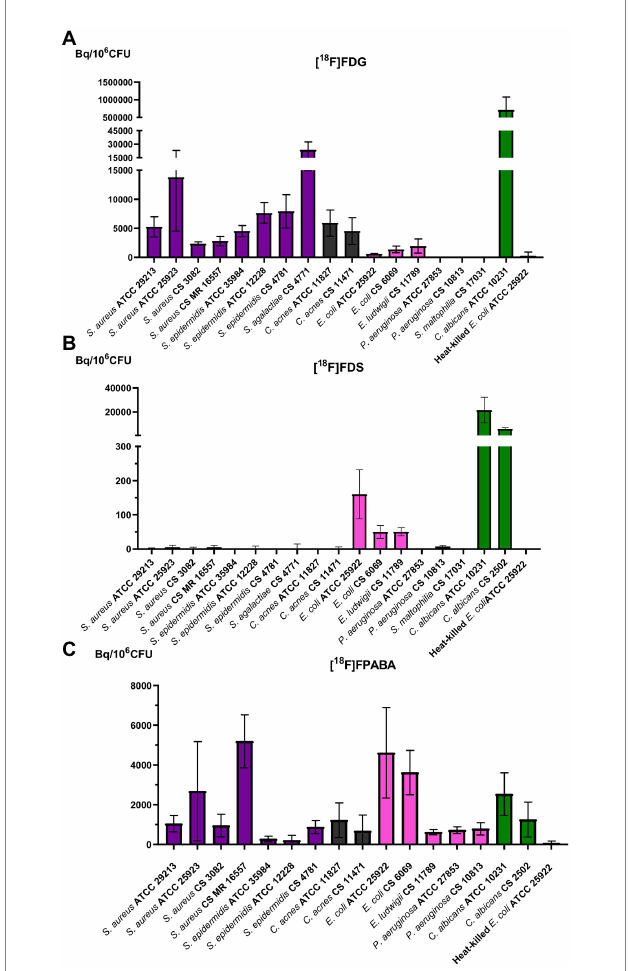
FIGURE 3 Cellular uptake of different probes tested after 2 h of accumulation. Purple: Gram-positive bacteria. Gray: Cutibacterium acnes . Pink: Gram-negative bacteria. Green: yeasts. CS: clinical strain. (A) [ 18 F]FDG; (B) [ 18 F]FDS; and (C) [ 18